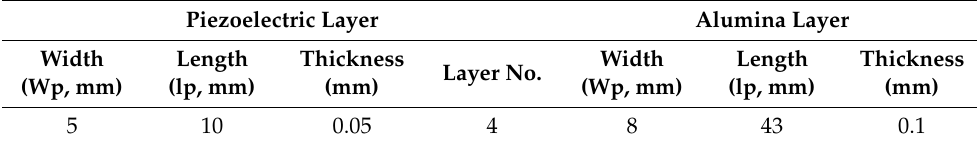
Table 1. Geometry of piezoelectric generator fabricated in the present